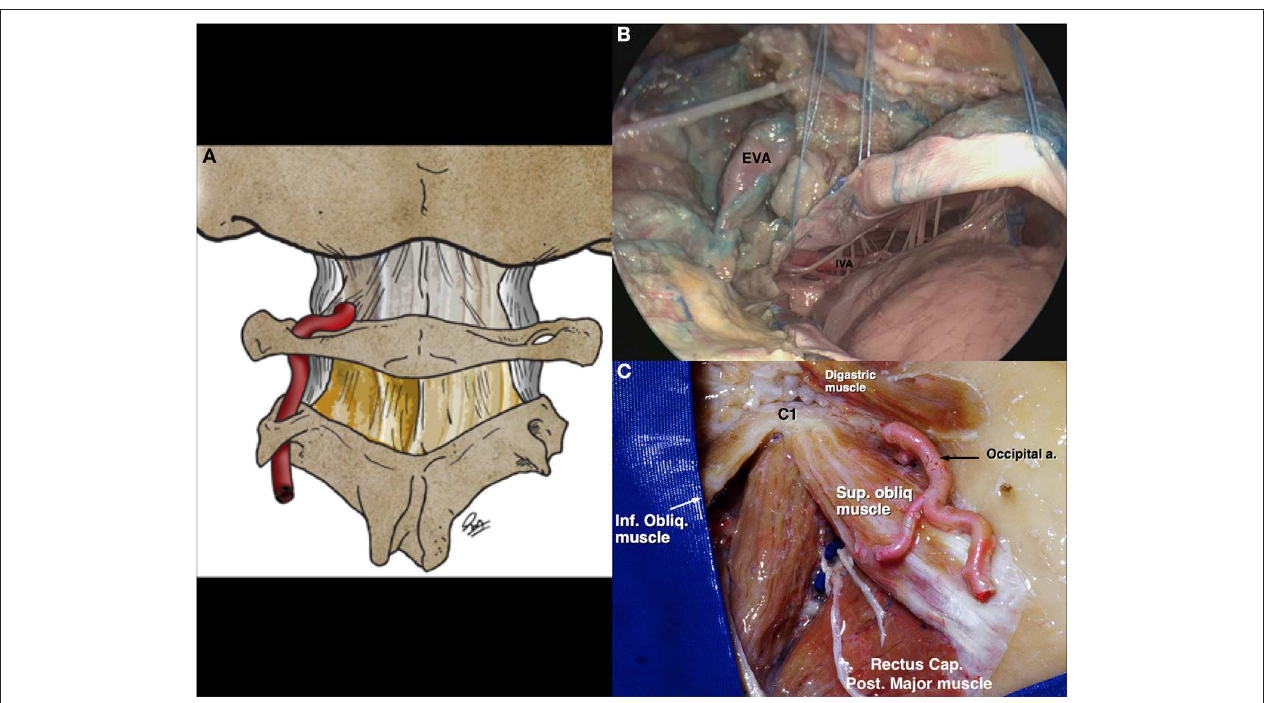
FIGURE 10 | Vertebral artery in the skull base [Modified from Ramina and Tatagiba (3)]. (A) Schematic drawing of the course of the cranial vertebral artery before perforating the atlanto-occipital membrane. (B) Cadaveric view of the vertebral artery entering the skull, and its relationship with bulbar nerves. (C) Suboccipital triangle, limited by the rectus capitis posterior major, superior oblique, and inferior oblique muscles. EVA, extracranial vertebral artery; IVA, intracranial vertebral artery.